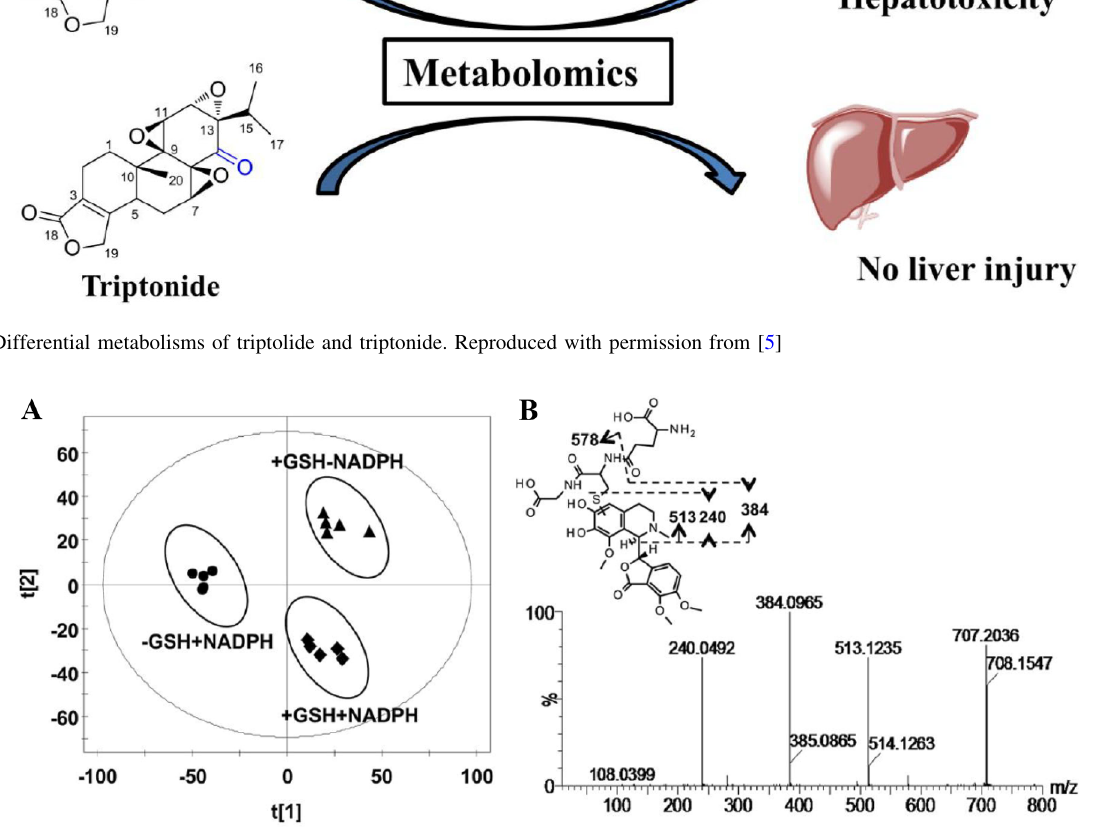
Fig. 10 Metabolomic analysis of GSH adducts in the HLM incubation system. a Scores scatter plot of OPLS-DA model. b The MS/MS fragments and proposed structure of the GSH adduct. Reproduced with permission from